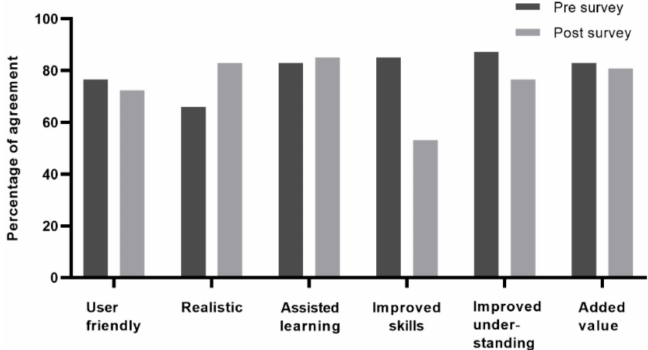
Figure 2. Comparison of pre- and post-training survey